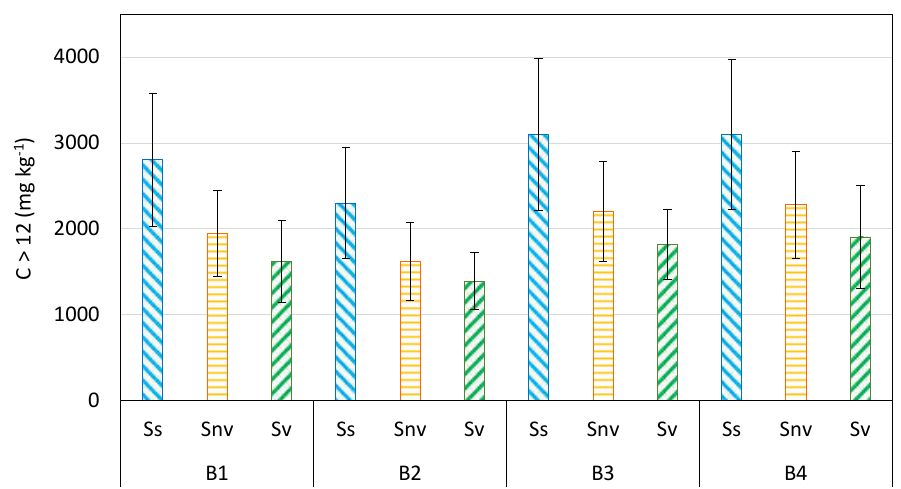
Figure 7. Concentration of the residual hydrocarbons in the four soils, B1, B2, B3 and B4, with the comparison between the starting soil (Ss, light blue bars), the non-vegetated soils (Snv, orange bars) and the vegetated ones (Sv, dark green bars) with Z. mays .